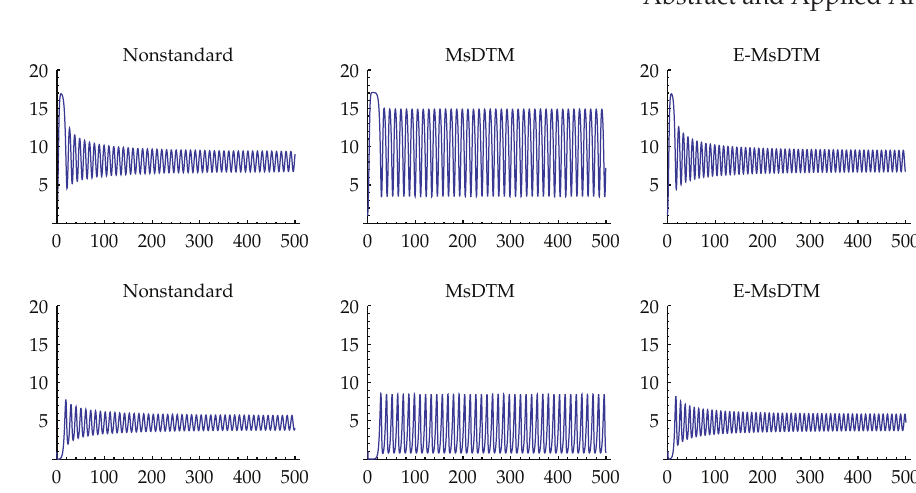
Figure 9: x (cid:4) t (cid:5) (cid:4) Top (cid:5) and y (cid:4) t (cid:5) (cid:4) Bottom (cid:5) ; nonstandard scheme (cid:4) Left, h (cid:8) 0 . 01 (cid:5) , MsDTM (cid:4) Middle, h (cid:8) 0 . 25 (cid:5) , E-MsDTM (cid:4) Right, h (cid:8) 0 . 25 (cid:5) ; k (cid:8) 17 . 1.